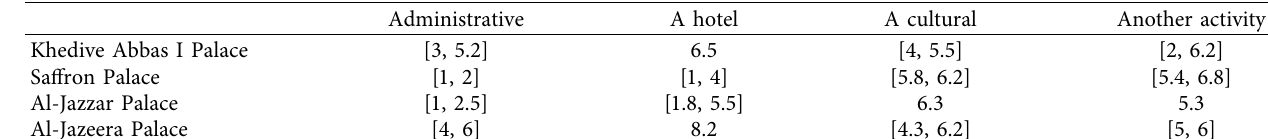
Table 19: Comparison of the four palaces.